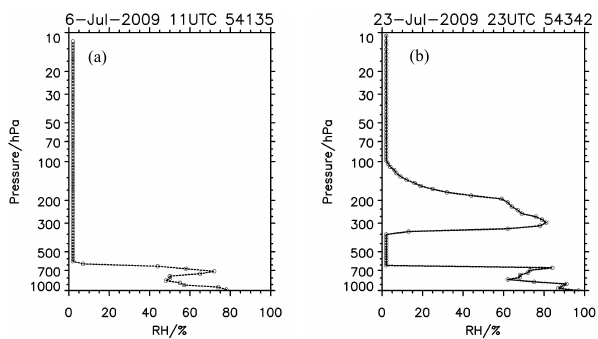
Figure 1. Two examples of abnormally dry profiles of relative humidity from the Chinese L-band radiosonde system. Source: Tang et al. (2014).